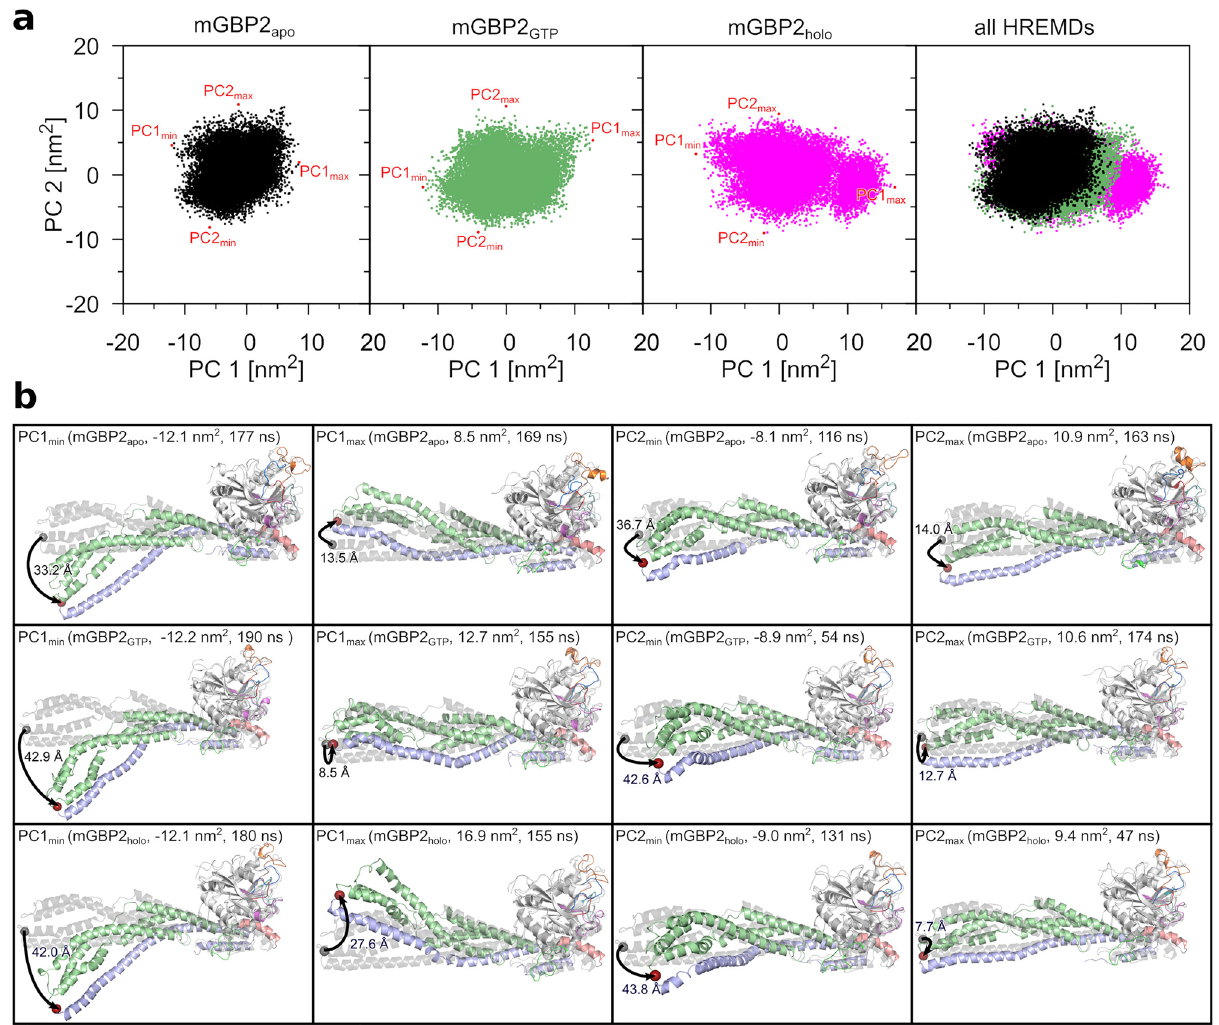
Figure 4. Main motions of the M and E domain in monomeric mGBP2 identified by PCA of the target replica of the HREMD simulations. ( a ) The projection of the conformations collected in the target replica onto the first two principal components (PC1 and PC2). The results for GTP-free mGBP2 (black), mGBP2 with GTP bound (green), and mGBP2 with both GTP and geranylgeranyl anchor (magenta) are shown from left to right. For a better comparability, all three projections are shown together in the rightmost panel. The minimum and maximum values of the projections are indicated by red dots and labeled. ( b ) The conformations at the minimal and maximal PC1 and PC2 values are shown for the mGBP2 apo (top), mGBP2 GTP (middle) and mGBP2 holo (bottom). The corresponding PC1 and PC2 values are provided too, along with the simulation time at which these conformations were sampled. The motions of the tip of the M/E domain relative to the starting structure (gray cartoon) are indicated by arrows and the maximal amplitudes (in Å) are